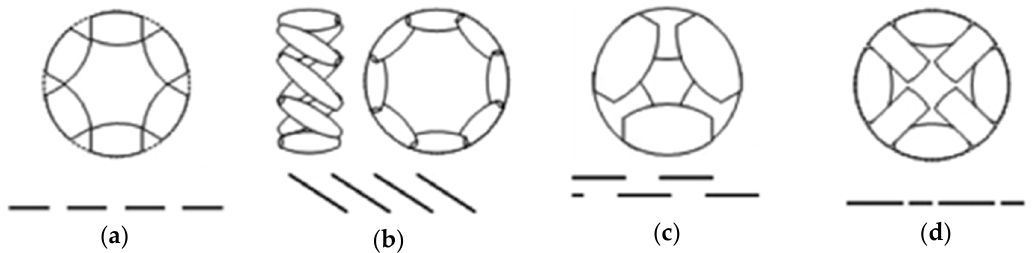
Figure 1. Types of omnidirectional wheels and their traces: ( a ) multiple passive rollers (or inner passive wheels) in which the axes are positioned tangent to the main wheel circumference; ( b ) with the rollers arranged in an overlapping way where the contact between the wheels and the ground is continuous; ( c ) based on two overlapping parallel wheels; ( d ) based on using alternating passive rollers with different size and shape.